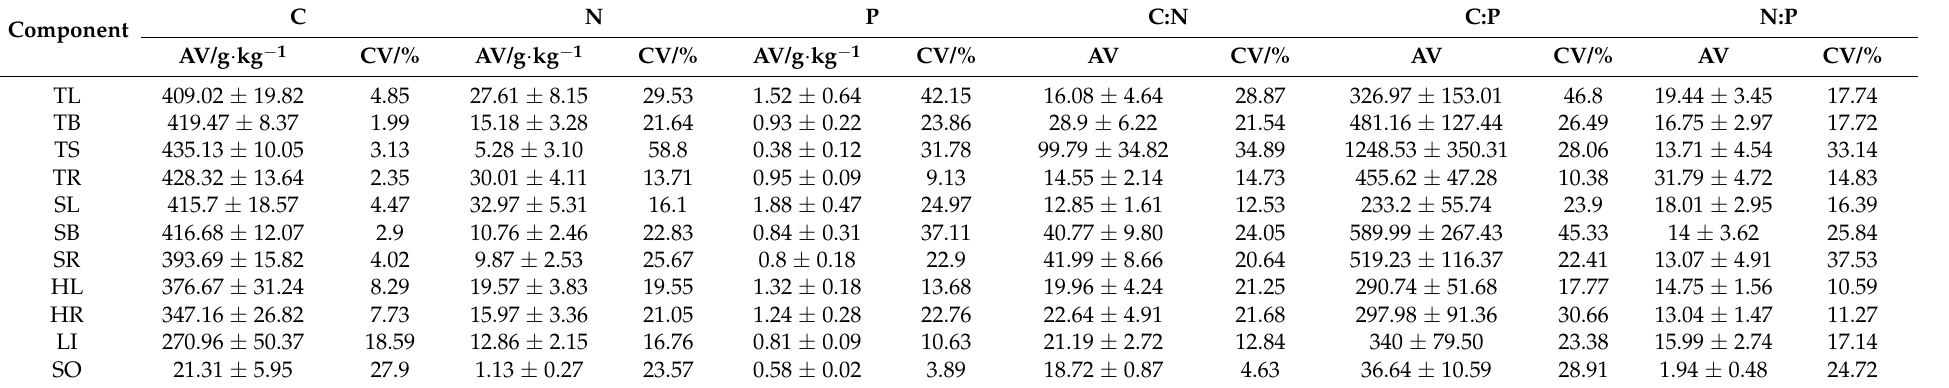
Table 1. Variation characteristics of various components of the Robinia pseudoacacia plantation ecosystem ( n =